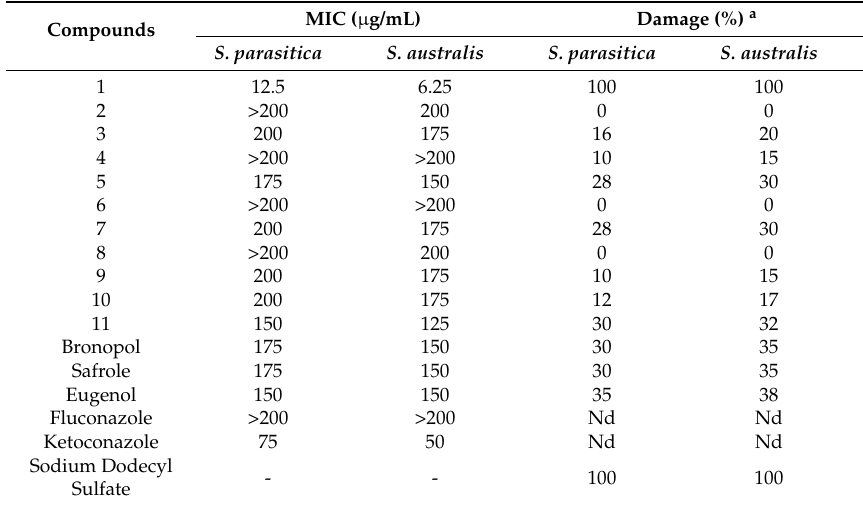
Table 1. Minimum inhibitory concentrations (MIC) and damage values of oxyalkylchalcones 1 – 11 against Saprolegnia species.